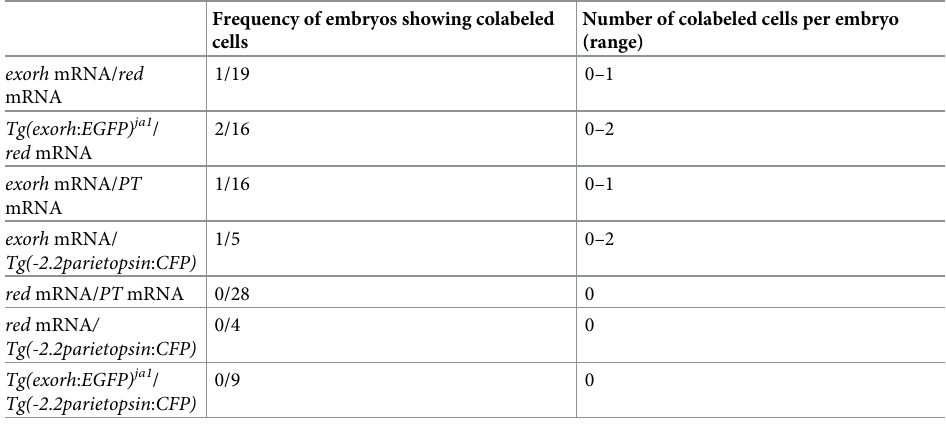
Table 1. Quantification of cells coexpressing two different opsins. The frequencies of embryos showing colabeled cells and number of colabeled cells per embryo are given for each of the combinations indicated on the left. Since cola- beled cells are observed in only a fraction of embryos and only a few cells in these embryos, our interpretation is that these cells do not constitute a population of PhR with mixed identity but rather represent an inappropriate specifica- tion event. Underlying data can be found in S1